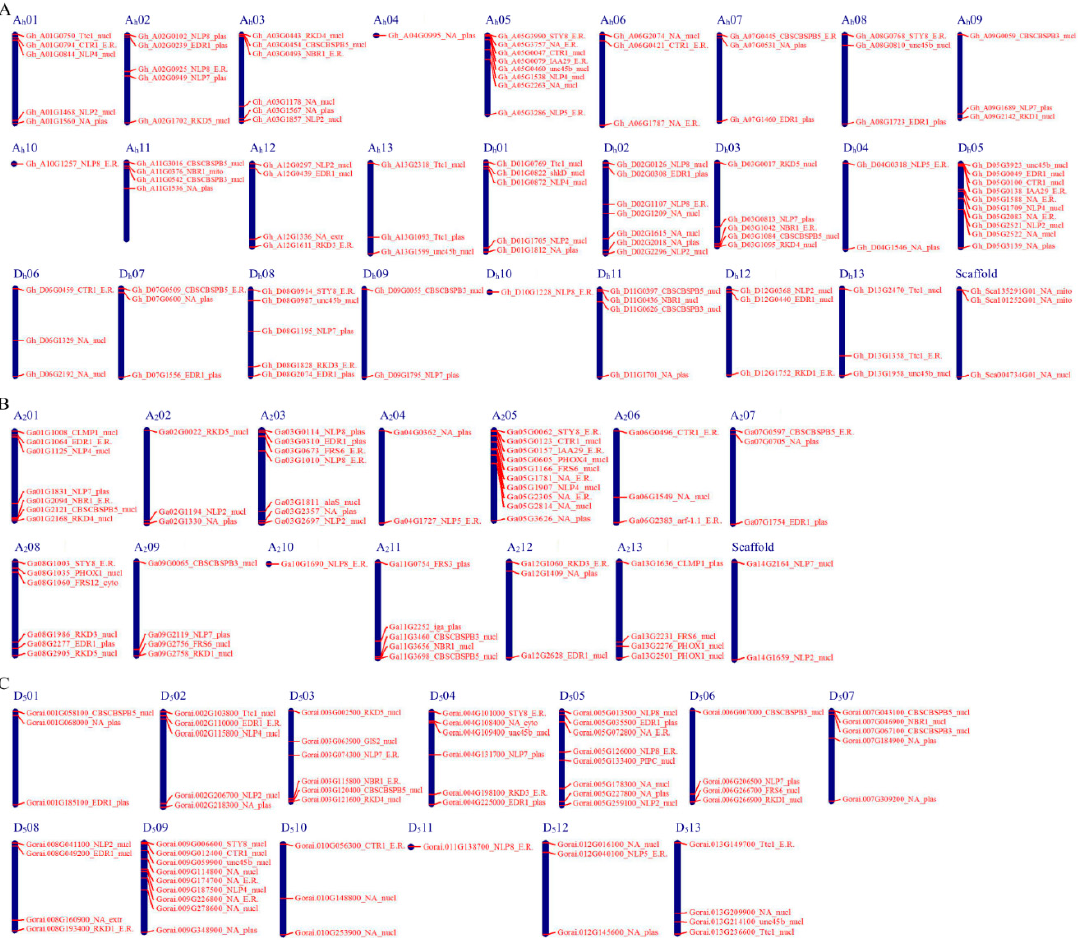
Figure 2. Chromosome mapping of the cotton NLP genes. ( A ) NLP genes mapped on G. hirsutum chromosomes. ( B ) NLP genes for diploid cotton, G. arboreum of the A genome. ( C ) NLP genes for G. raimondii diploid cotton of the D genome.